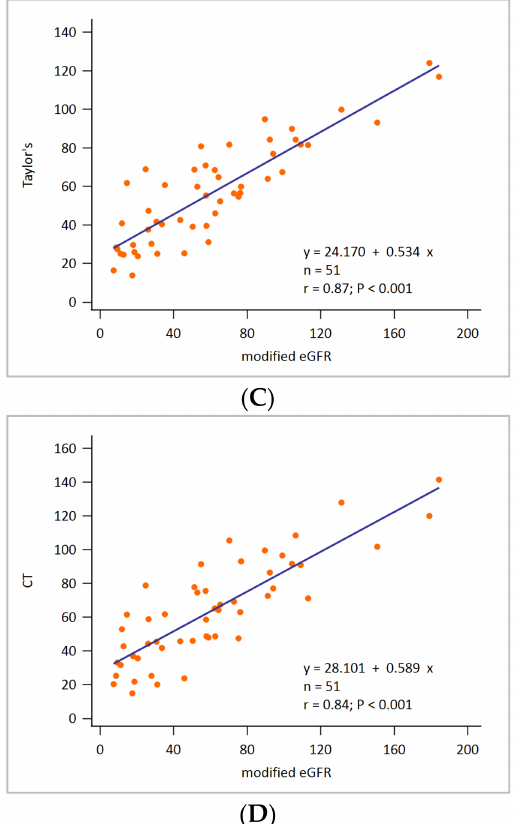
Figure 3. The correlation between GFRs calculated using renal depth by four ways and modified eGFR. ( A ), the GFR calculated using the renal depth estimated by Tonnesen’s formula (r = 0.87, y = 0.476x + 16.477). ( B ), the GFR calculated using the renal depth estimated by Itoh K’s formula (r = 0.87, y = 0.560x + 20.879). ( C ), the GFR calculated using the renal depth estimated by Taylor’s formula (r = 0.87, y = 0.534x + 24.170). ( D ), the GFR calculated using the renal depth estimated by CT (r = 0.84, y = 0.589x +